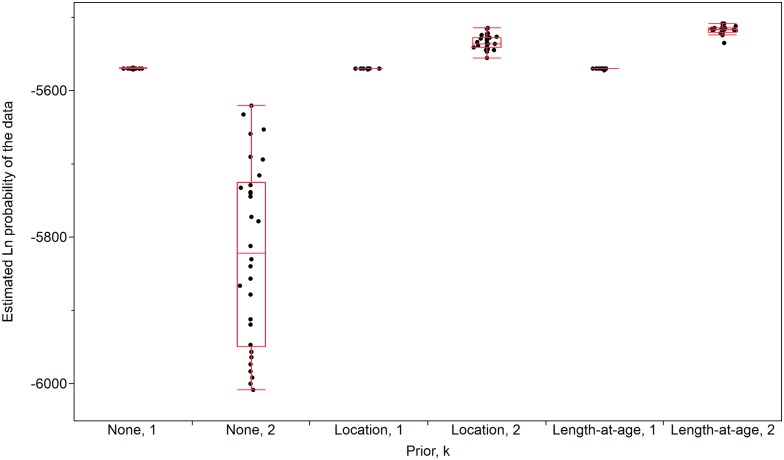
Results from STRUCTURE analysis used to identify the most likely Lake Sturgeon population structuring patterns in the vicinity of the Slave Falls GS, based on 10 microsatellite loci.Genotype data alone (none), and priors (sampling location [location], length-at-age) were considered in combination with putative populations (k) of 1–4. For illustrative purposes, only the most statistically probable scenarios (k = 1, 2) are shown. The synthesis of 30 iterations per combination is summarized using box plots.